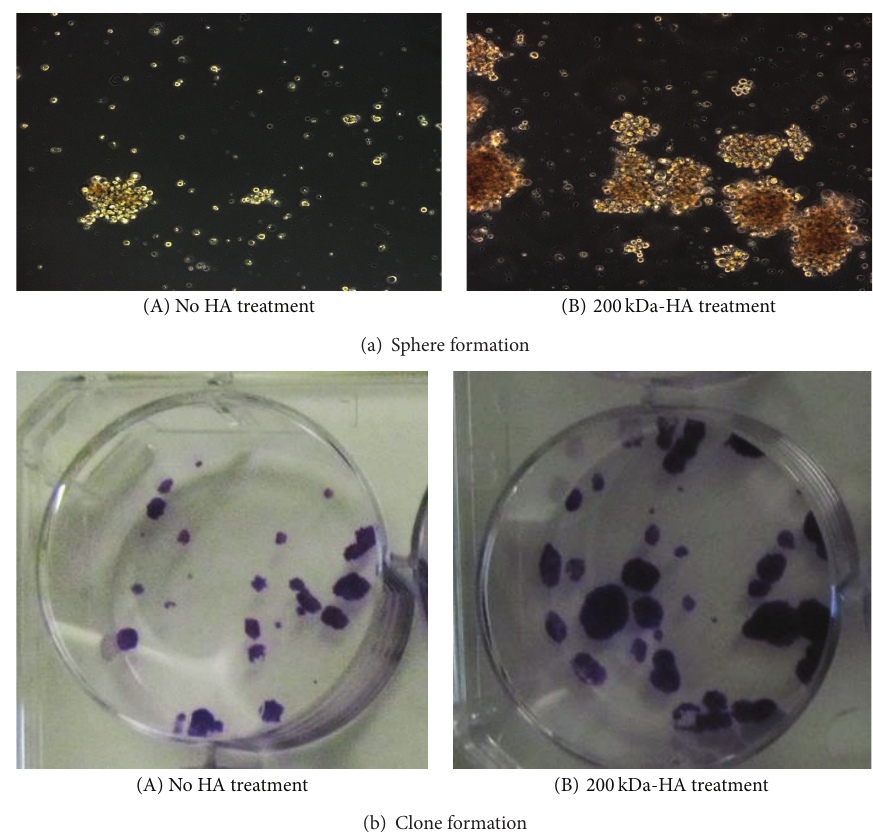
Figure 3: Measurement of sphere formation (a) and clone formation (b) CD 44 v 3 high ALDH 1 high (CSC) cells. (a) Sphere formation of CD 44 v 3 high ALDH 1 high cells [treated with no HA (A) or with 200kDa-HA (B)] in a mixture of 5mg/mL of matrigel (Corning) and defined medium (RPMI-1640 medium containing EGF and bFGF without serum) for 3 weeks (21 days) as described in Section 2. (b) Clone formation (differentiation) of CD 44 v 3 high ALDH 1 high cells pretreated with no HA (A) or with 200 kDa-HA (B). Specifically, clone formation and differentiation were induced by incubating CD 44 v 3 high ALDH high cells (dissociated from spheres treated with 200 kDa-HA or without HA for 10 days as described above). After the removal of 200 kDa-HA from the cells, these sphere-derived CD 44 v 3 high ALDH high cells were then incubated in RPMI 1640 complete culture and 10% fetal bovine serum for ∼ 7–10 days. After most cell clones expand to > 50–100 cells, they were fixed with methanol followed by staining with crystal violet to visualize clone formation as described in Section